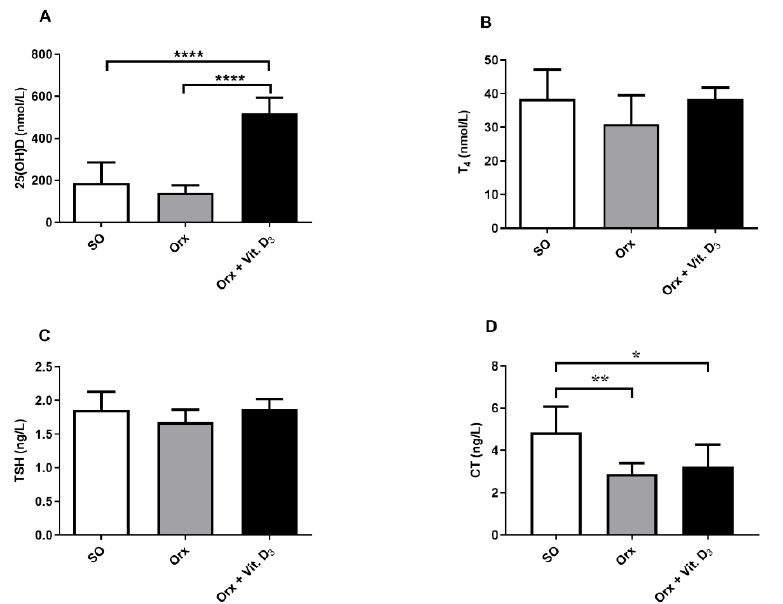
Figure 1. Concentration of total 25-hydroxyvitamin D (25-(OH)D; nmol/L; ( A ), total thyroxine (T 4 ; nmol/L; ( B ), thyroid stimulating hormone (TSH; ng/L; ( C ), and calcitonin (CT; ng/L; ( D ) in serum of sham-operated (SO), orchidectomized (Orx), and orchidectomized cholecalciferol- treated (Orx + Vit. D3) rats. The data are mean ± SD, n = 6; * p < 0.05; ** p < 0.01; **** p < 0.0001.